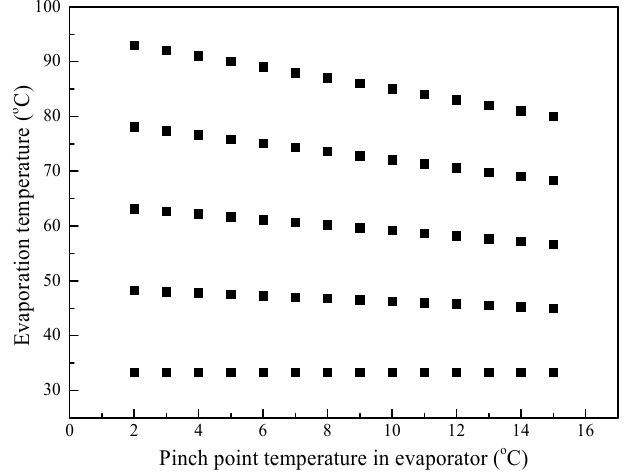
Figure 7. The coupling effect between the pinch-point temperature in the evaporator and the evaporation temperature.